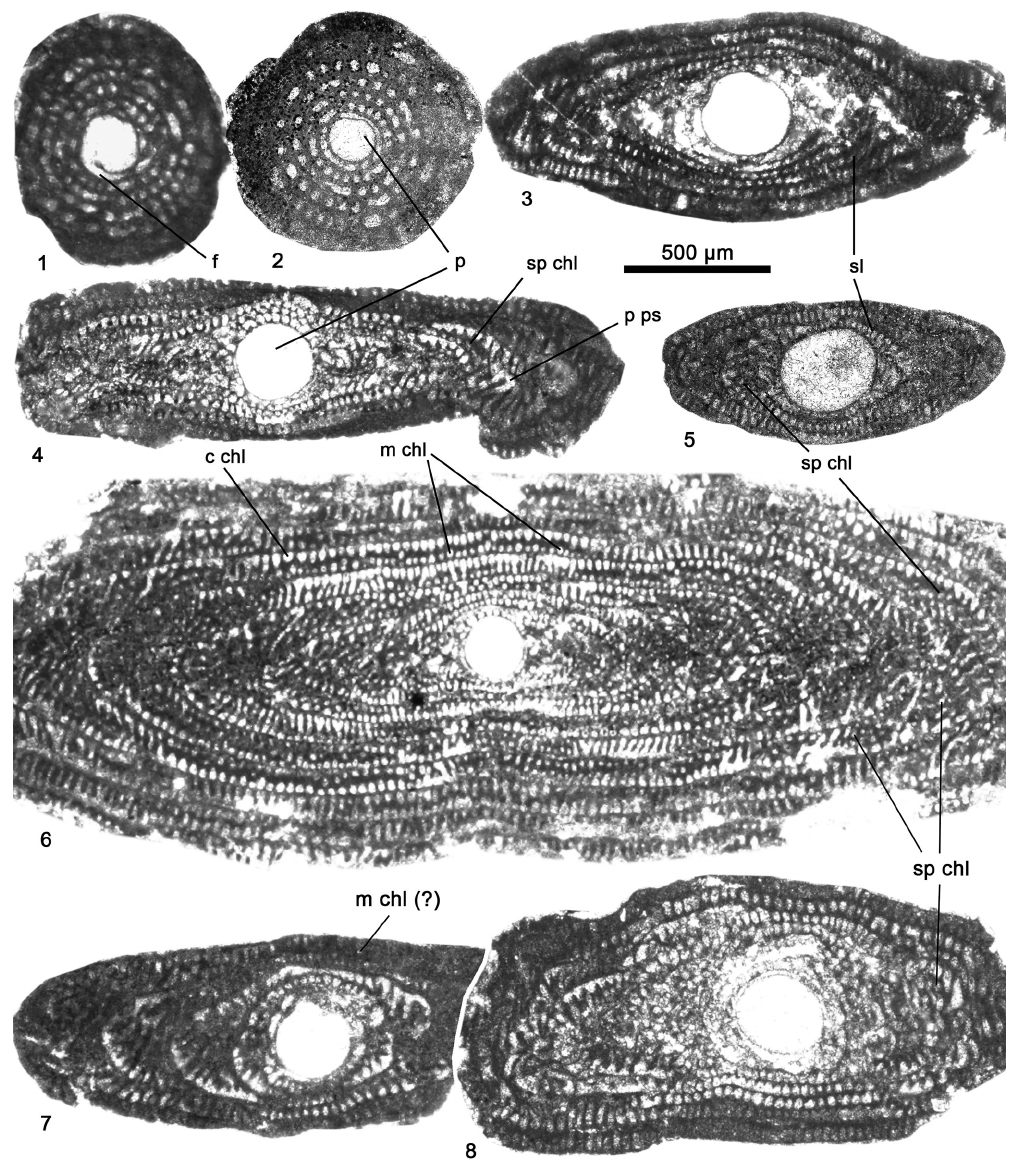
Figure 8. (1, 2) Simplalveolina mardinensis ? n. sp. (gamonts?); (3–7) Decastroia oblonga Vicedo and Piuz ( 3–5 and 7 , juvenile specimens); and 8, Praealveolina cf. arabica Vicedo and Piuz from the middle Cenomanian, Derdere Formation at Derik, Mardin, south-eastern Turkey. Transmitted light photographs of thin sections of cemented carbonate rocks. Specimens are cut off from the surrounding matrix: (1,